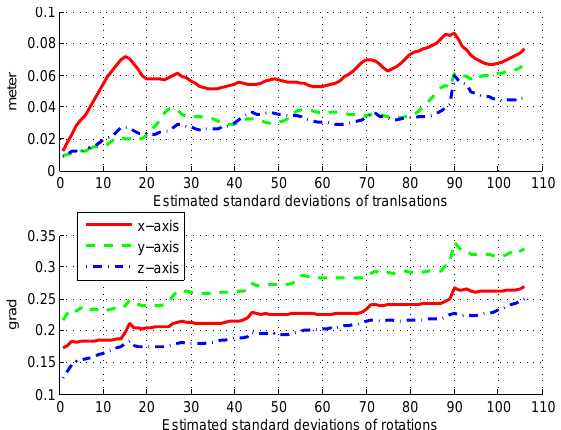
Figure 10: Estimated standard deviations of the estimated rota- tion angles and translations of BACS on all set of keyframes. All are up to the fourth digit identical to these provided by iSAM2. The axes are oriented as described in Fig.